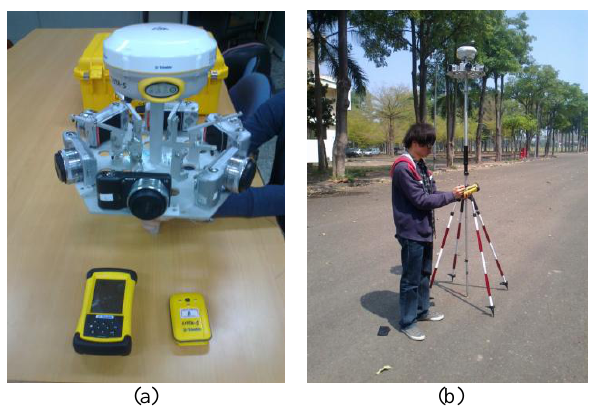
Figure 1. (a) A picture of the PPIMS; (b) The system is set up on a surveying rod.